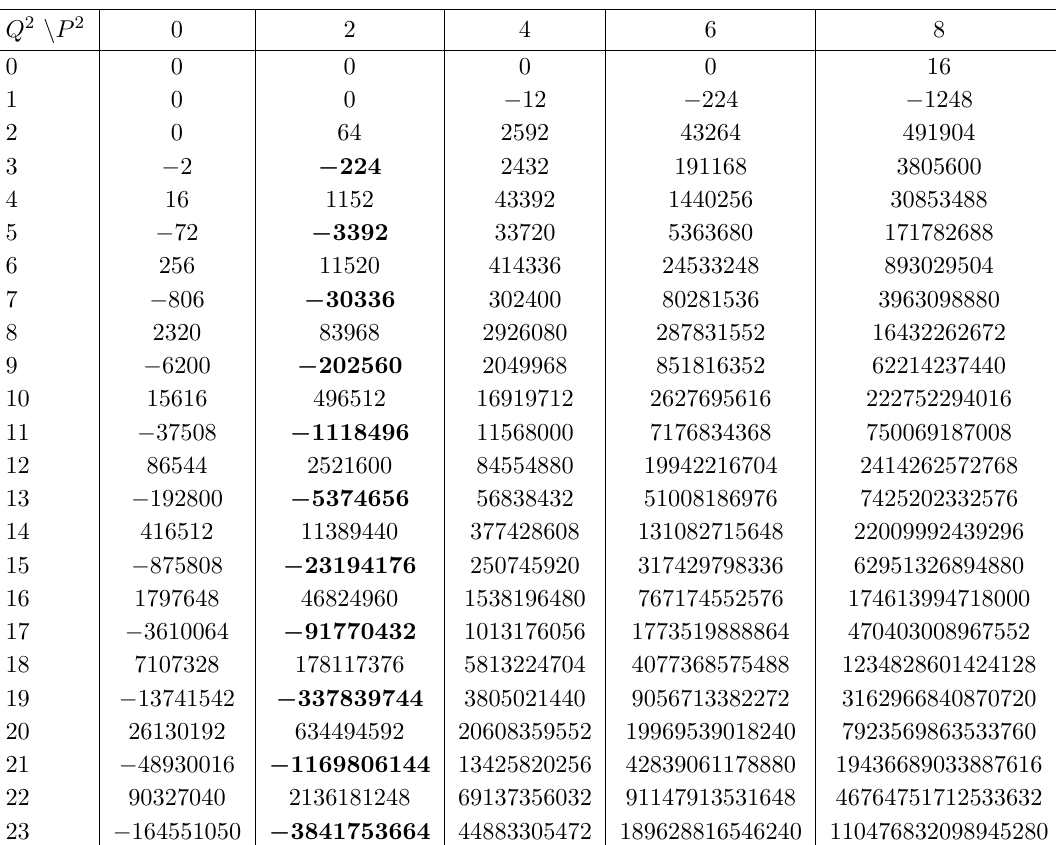
Table 19 . The index d ( Q; P ) for the Z 2 toroidal orbifold some low lying values of Q 2 , P 2 with Q (cid:1) P =